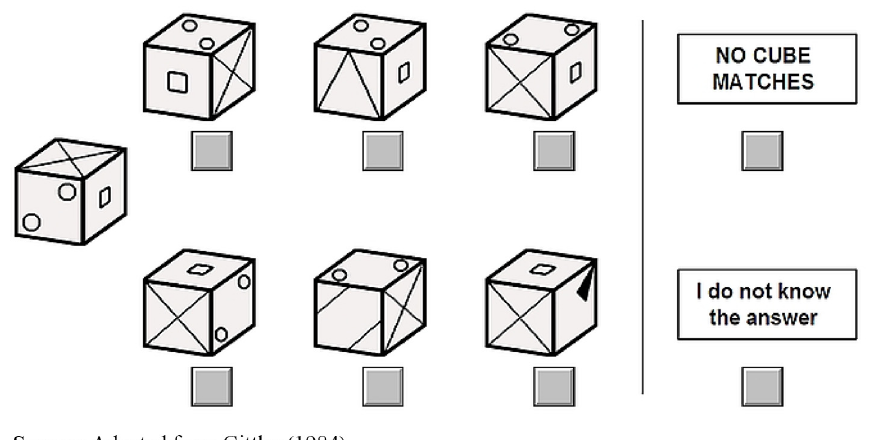
Figure 2. A typical question on